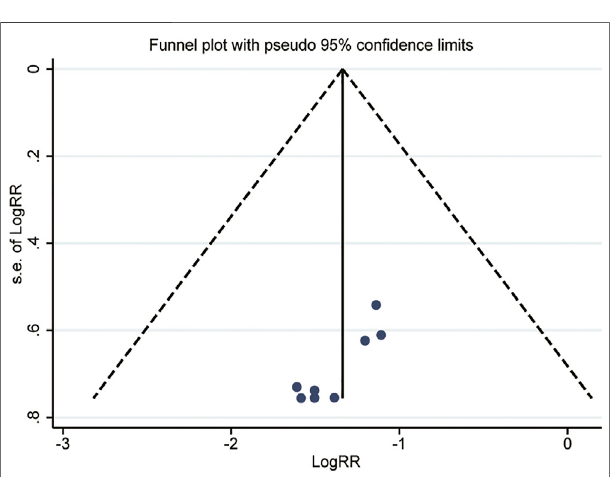
FIGURE 7 | Funnel plot of the recurrence